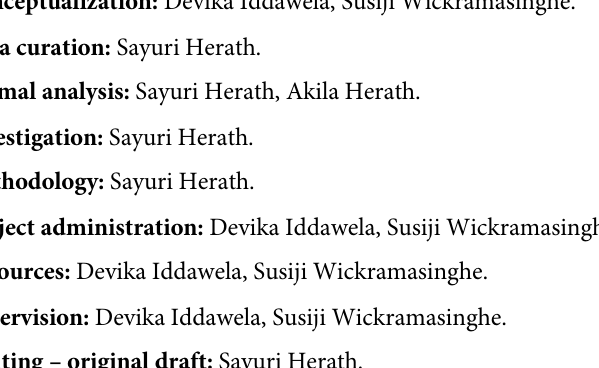
S1 Table. Statistical analysis. Chi-square test and Fisher’s test. S1 Fig. Light microscopic view of Trichomonas trophozoites. A: Trichomonas trophozoites